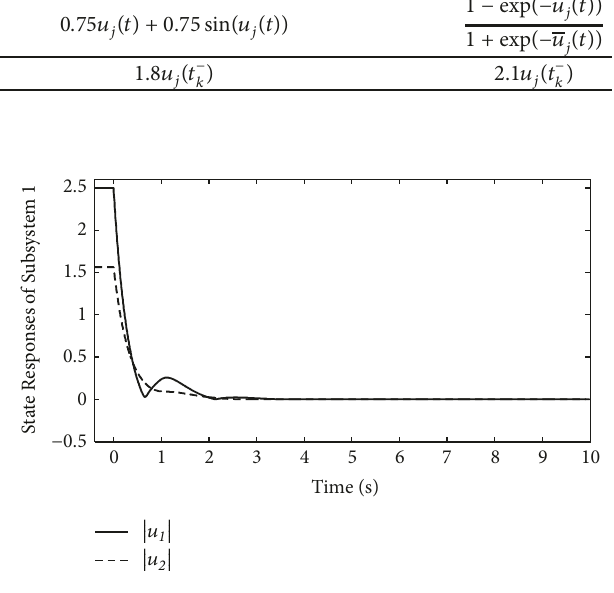
Figure 1: State curves of subsystem 1 in (2).